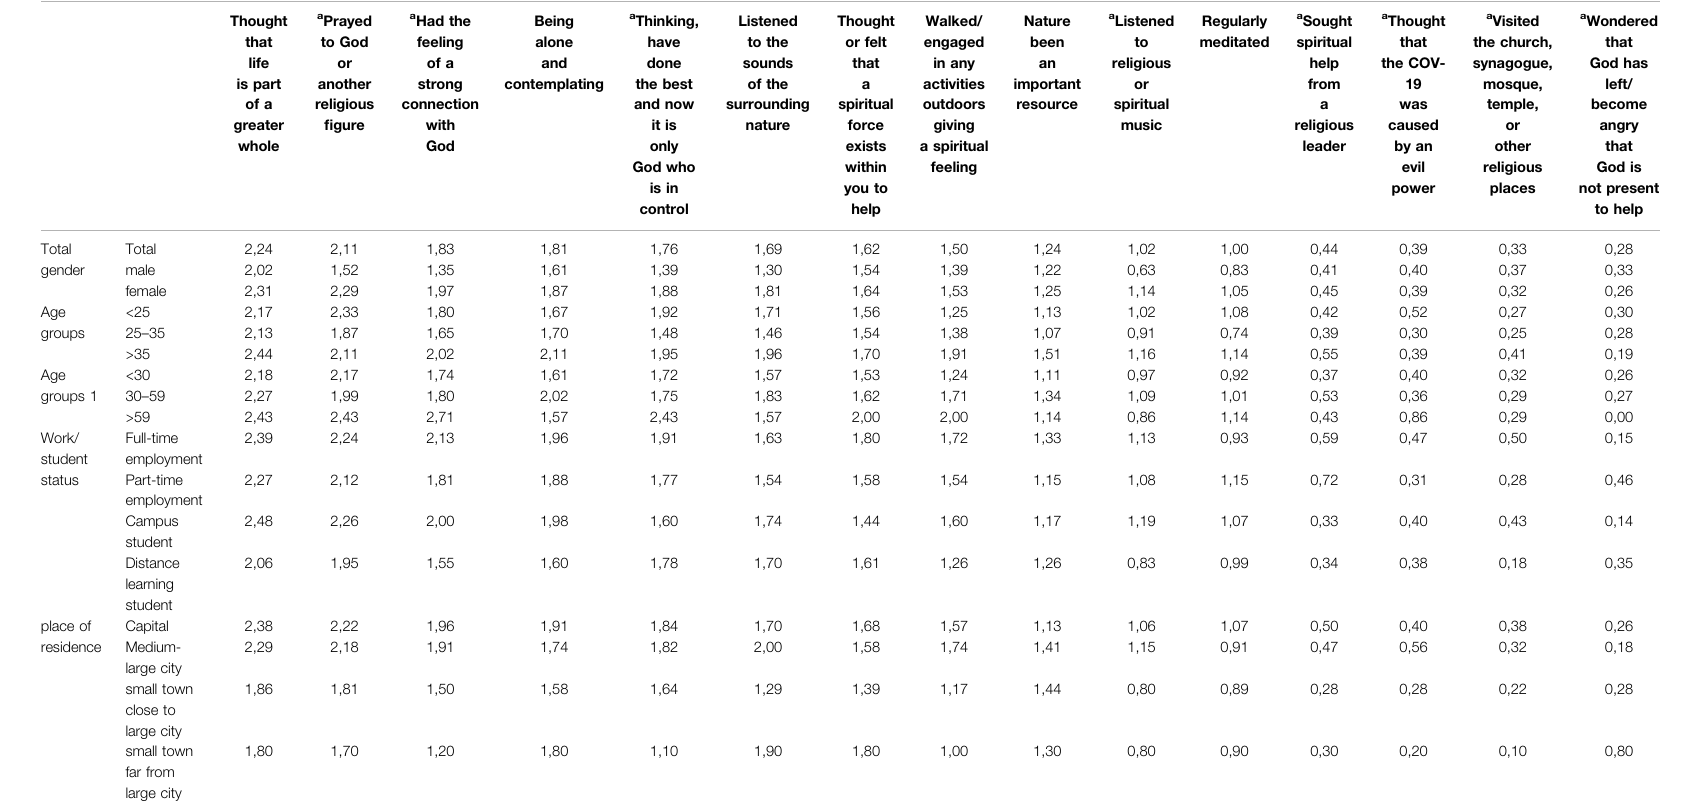
TABLE 2 | Horizontal analysis comparing meaning-making coping methods, by